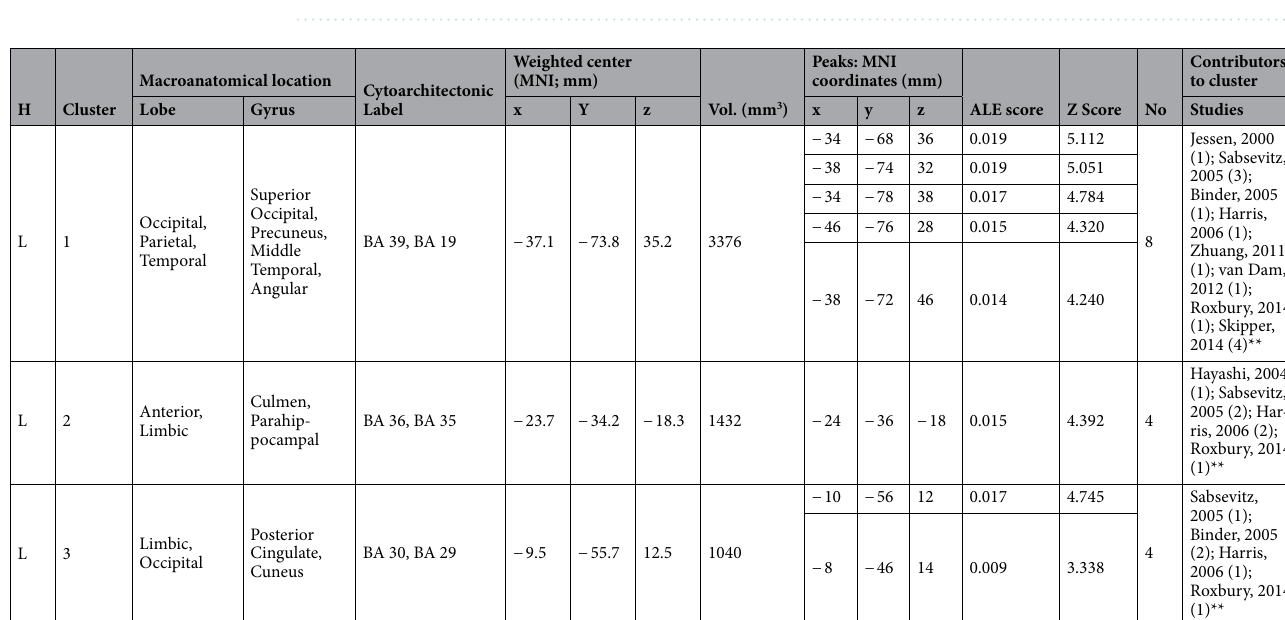
Figure 3. Clusters activated by the concrete > abstract nouns contrast. The crosses are centered in the areas correspond to stereotactic coordinates reported in Table 3. The images are presented in neurological convention.